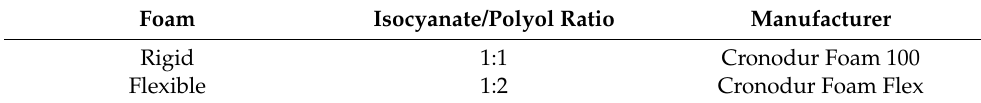
Table 1. Proportion of polyurethane foam reagents.